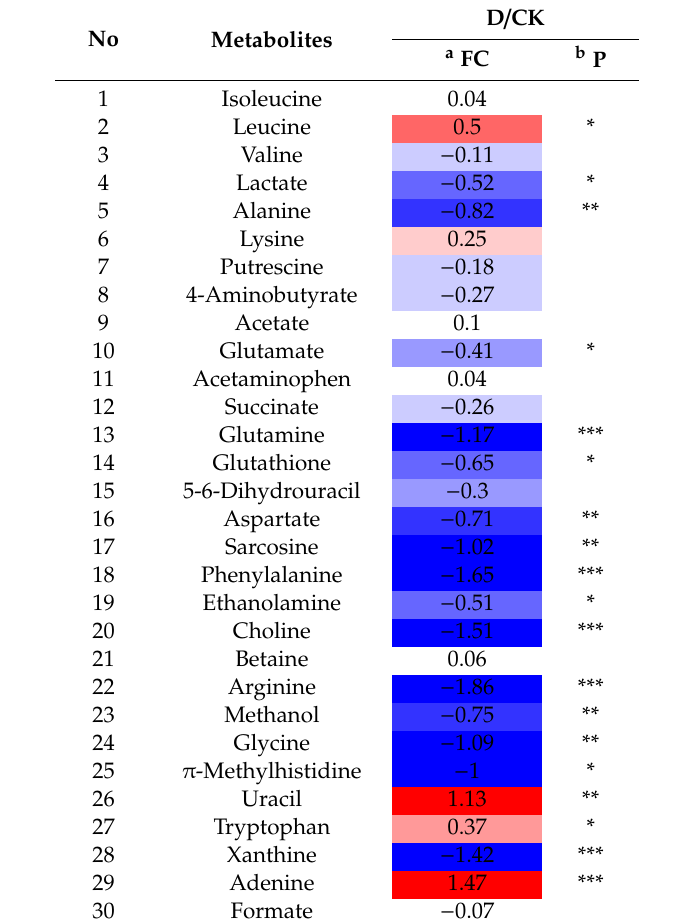
Table 2. Di ff erential expression of metabolites between two groups at 12 h.